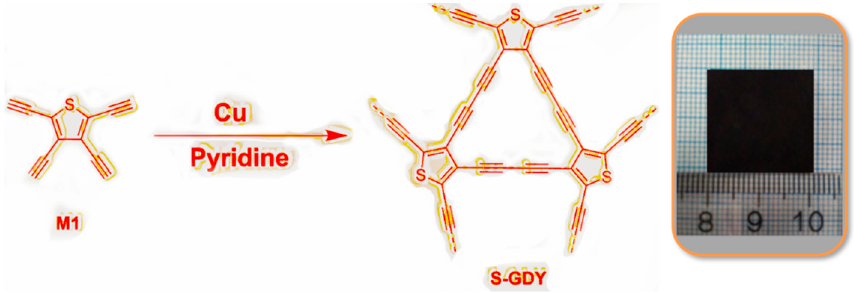
Figure 1. The preparation route and the photograph of S-GDY film on the copper foil.